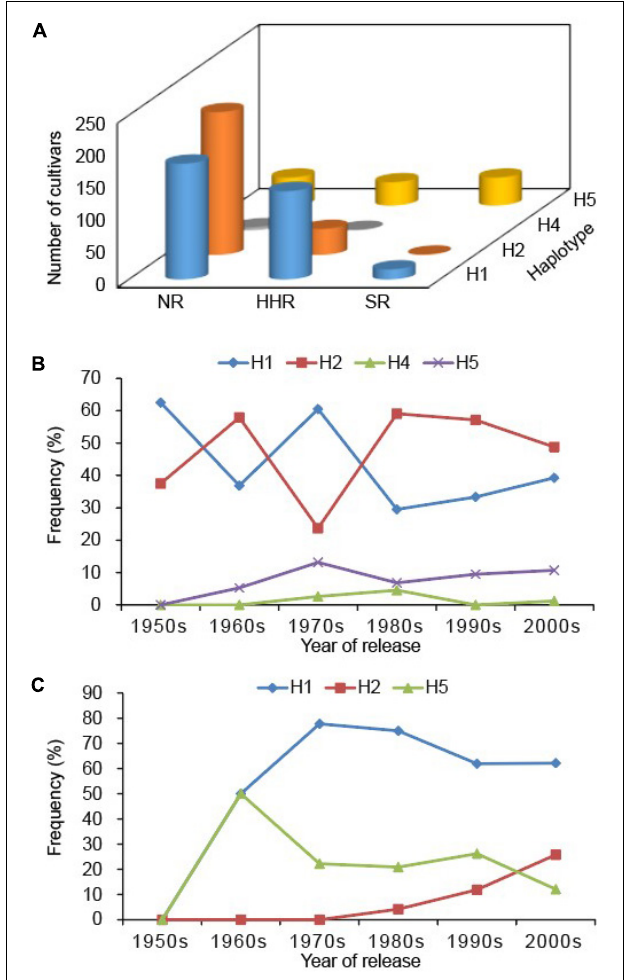
FIGURE 3 | GmSALT3 allele characterization in Chinese soybean varieties. Distribution of haplotypes among varieties from different ecoregions (A) ; Frequency changes of haplotypes in the northern region of China (NR) (B) ; and Huanghuai region of China (HHR) (C) over 60 years of soybean breeding. The distribution of H3 is not shown because only five cultivars expressed this